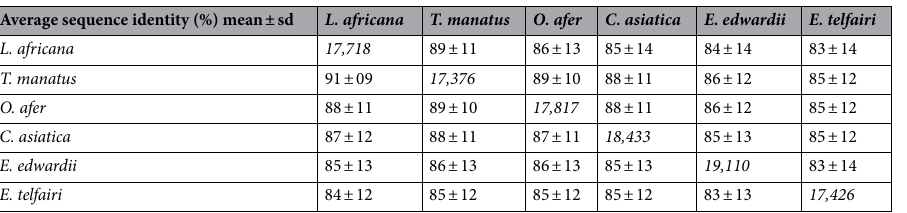
Table 1. Average pairwise sequence identity of Afrotherian proteome sequences. Numbers along the diagonal (in italics) indicate total number of canonical proteins considered for the homology